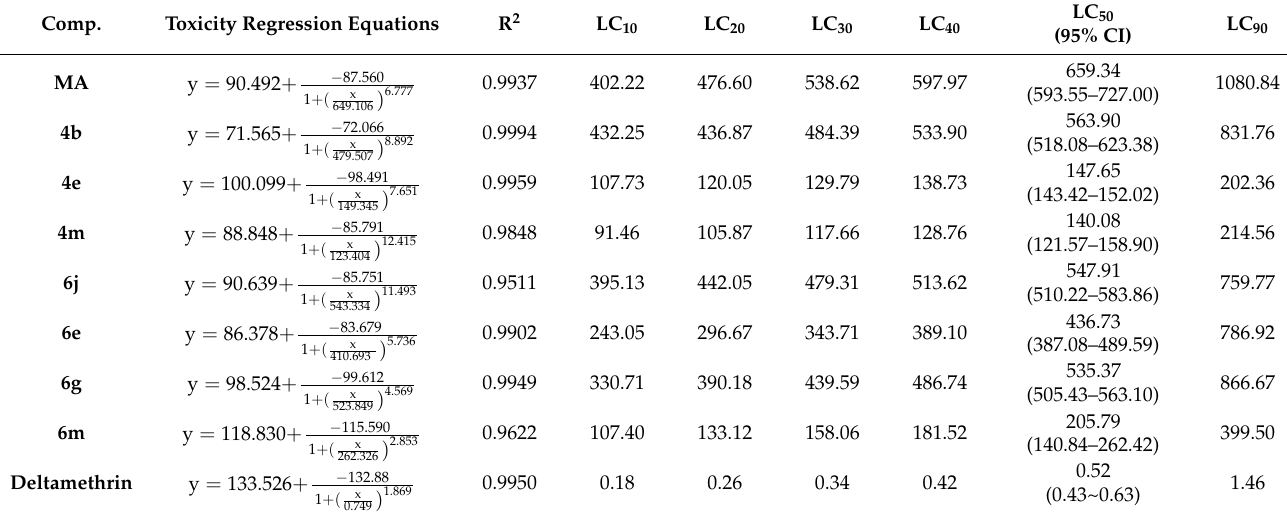
Table 2. The LC 20 , LC 50 , and LC 90 values against Ae. albopictus larvae.